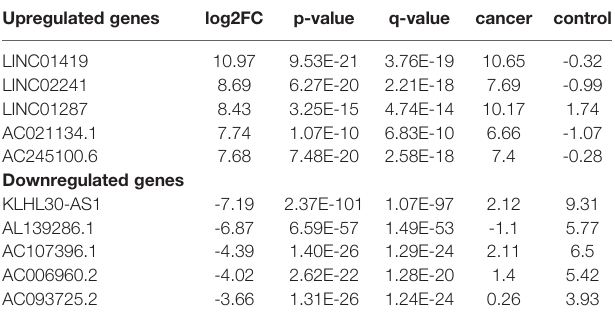
TABLE 2 | The differentially expressed genes (Top